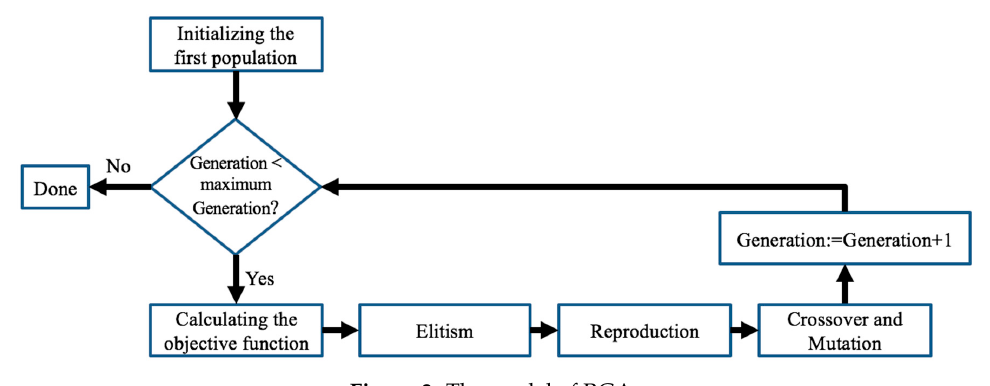
Figure 3. The model of RGA.